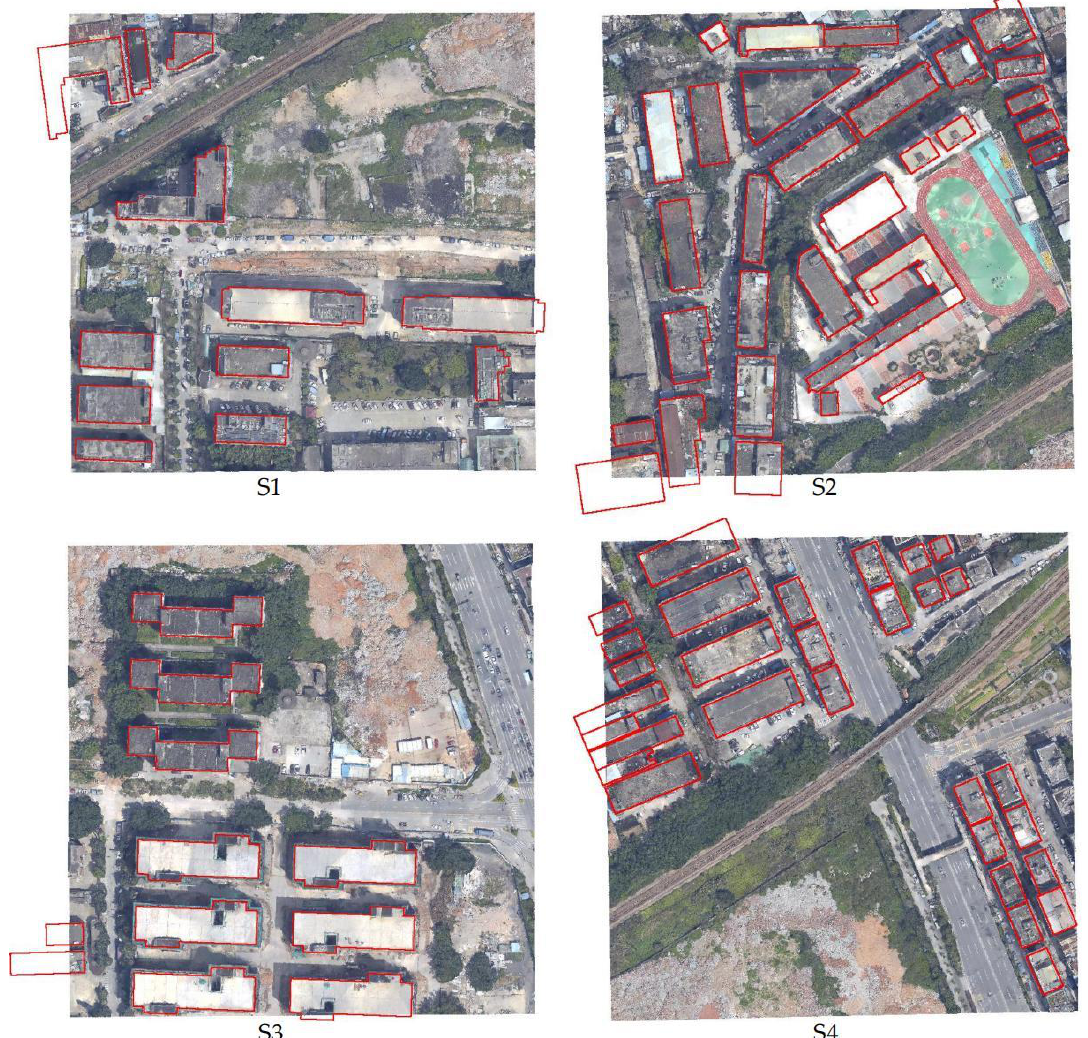
Figure 7. Four tiles of the photogrammetric point cloud and corresponding buildings footprint data (red polygons) in Shenzhen.